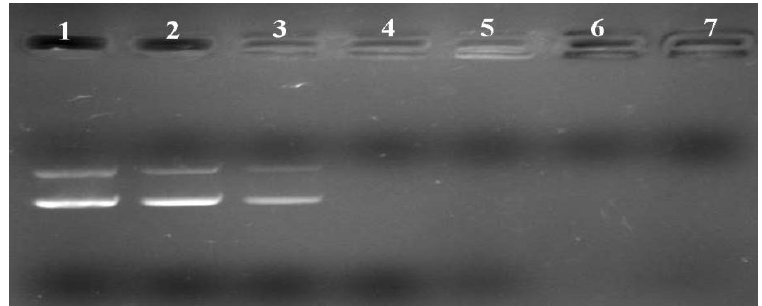
Figure 4. Gel retardation assay of PLA-PEG-PLL NPs/DNA complexes prepared at different N/P ratios. Lane 1: Naked DNA; Lane 2-7: The N/P ratios of